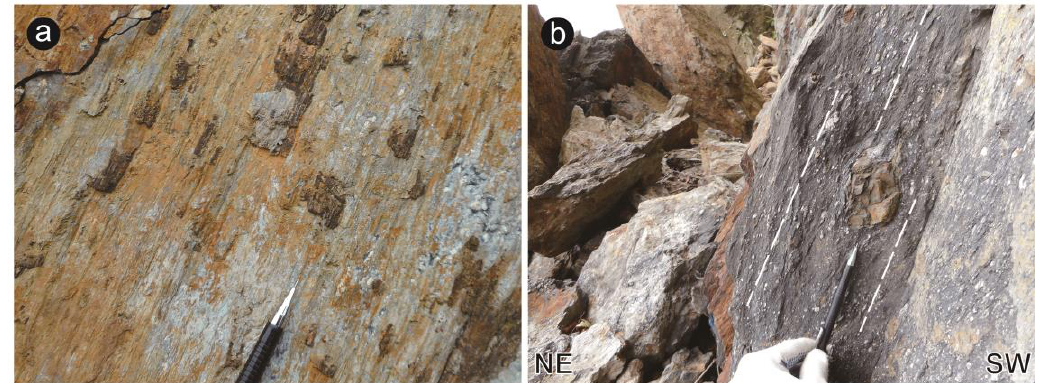
Figure 5. Outcrop photographs of a normal fault juxtaposing volcano-sedimentary sequences in the Deokjeok Formation and mylonite in the DSZ. ( a ) Slickenfibres on the fault surface indicative of top-down movement. ( b ) Foliated cataclasite zone along the normal fault.